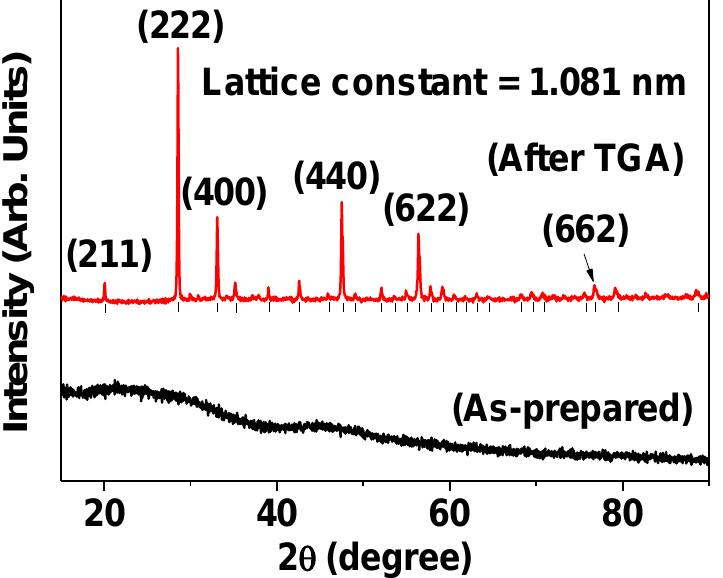
Figure 4. XRD patterns of PASA-coated Gd 2 O 3 nanoparticles before (bottom) and after (top) TGA. Vertical bars below the peaks after TGA indicate peak positions of cubic Gd 2 O 3 and only the strong peaks were assigned to ( hkl ) Miller indices.